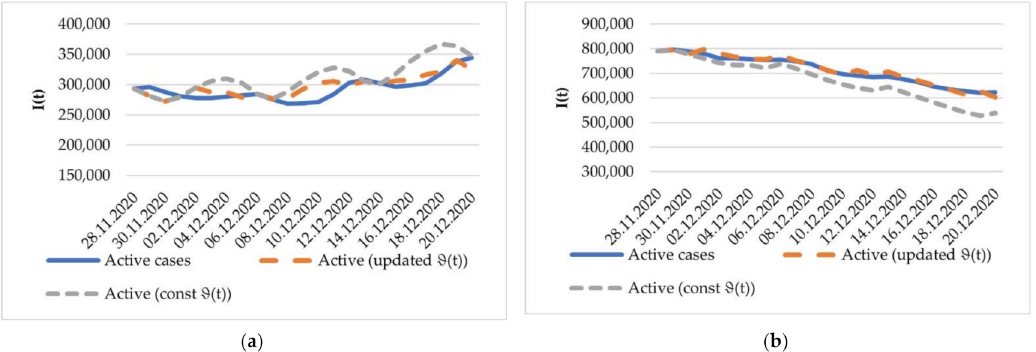
Figure 14. Dynamics of I ( t ) , the actual and calculated trajectories for the interval of 1 to 20 December 2020, in a stationary case and with the updated values of ϑ ( t ) , in ( a ) Germany and ( b ) Italy.